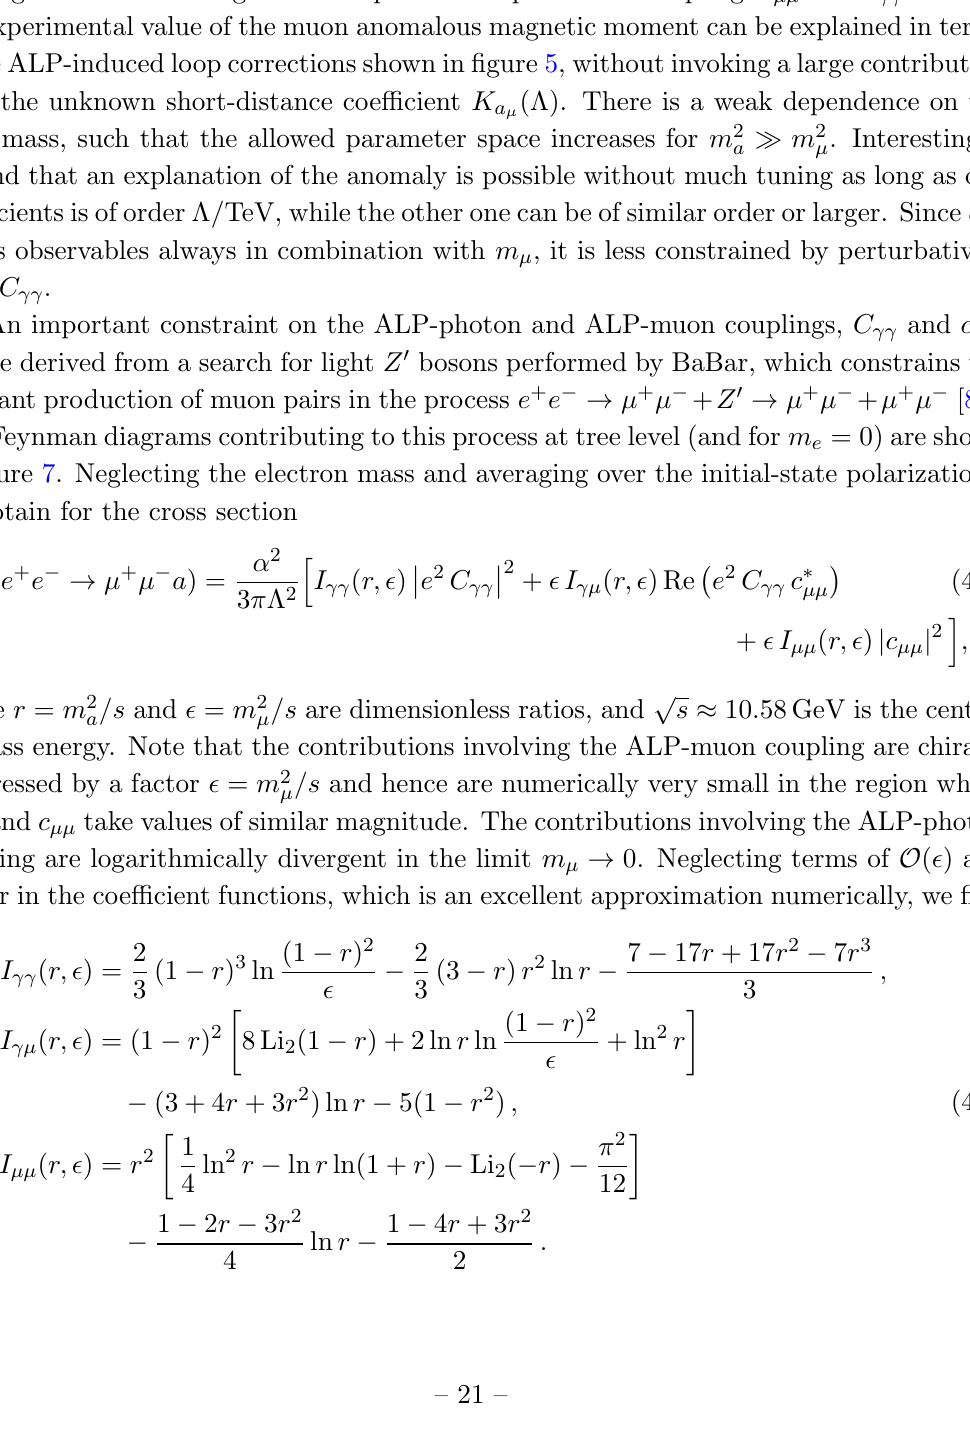
Figure 7 . Tree-level Feynman diagrams contributing to the process e + e